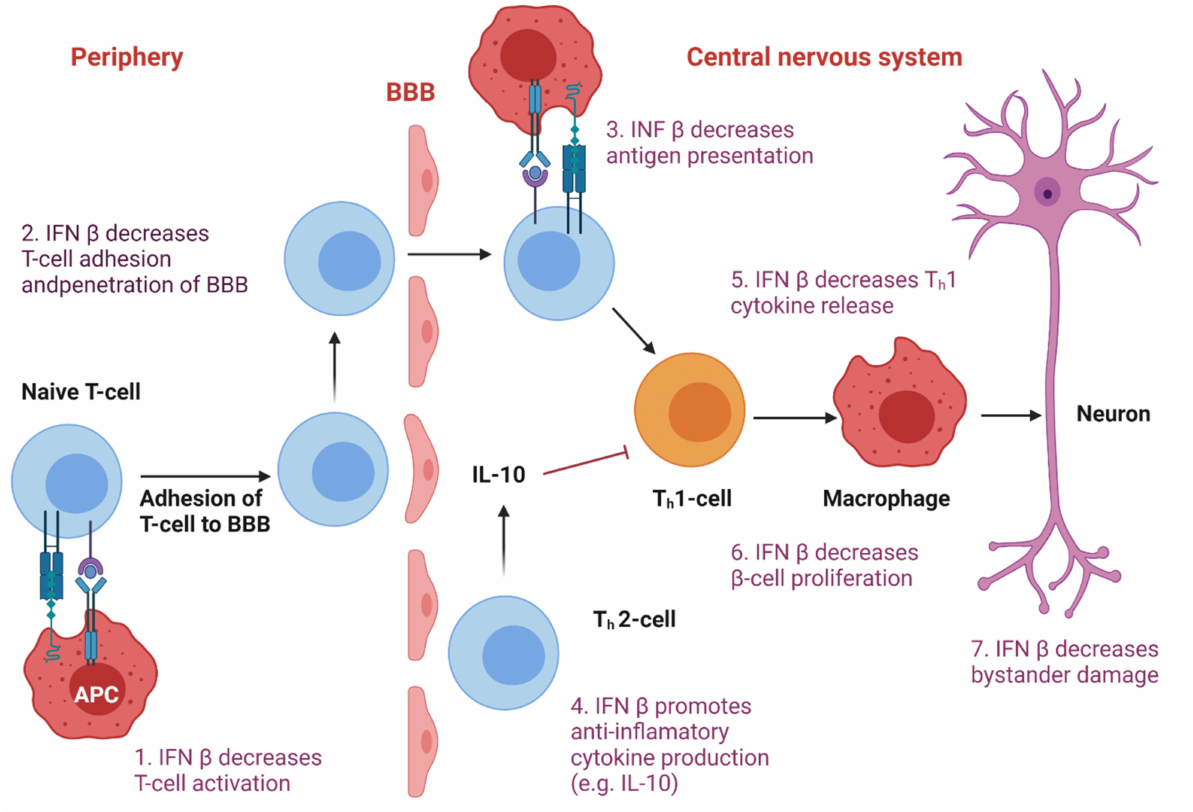
Figure 7. Biological activity of IFN β in autoimmune diseases. Its action directly increases the expression and concentration of anti-inflammatory agents and down-regulates the expression of proinflammatory cytokines. The same pathway that enables interferon beta’s biological effects mediates its mechanism of action in MS. This cytokine binds to its specific receptors IFNR I and IFNRII on the surface of the main cells of the immune system (DC, TH1 TH2, and B cells). Ligand-receptor binding triggers a cascade of events within these cells that results in positive feedback from the molecule, increasing IFN β levels and producing the expression of multiple ISGs such as MHC Class I, Mx protein, 2 (cid:48) /5 (cid:48) -oligoadenylate synthetase (OAS), β 2-microglobulin and neopterin. These products have been found in serum and cellular fractions of blood from patients treated with interferon-beta. Created with